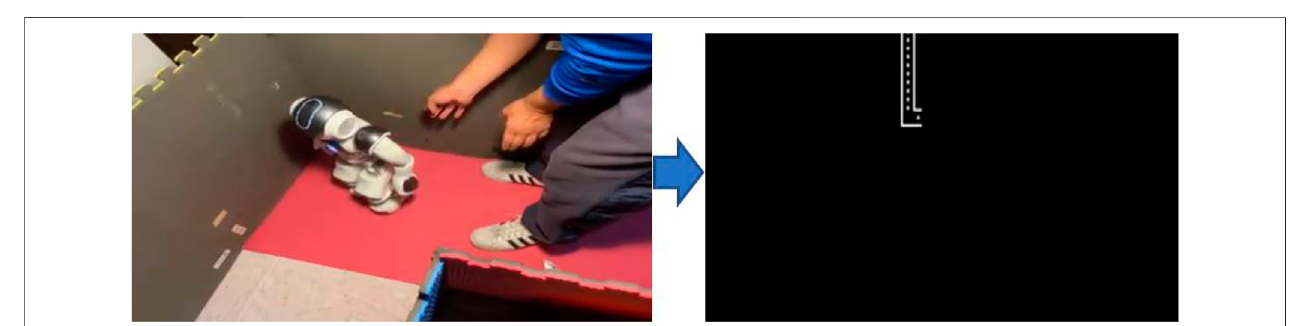
FIGURE 11 | Test: right